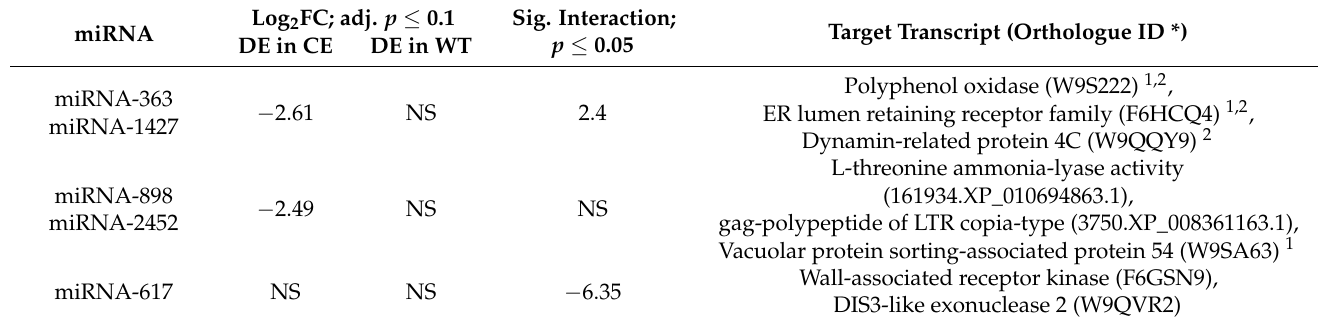
Sig. interaction is the difference between the condition effect for the resistant cultivar compared to the condition effect for the susceptible cultivar. * Orthologue ID is either UniProt (Entry) or STRING identifier. NS = not significant. 1,2 Significant genes identified in topGO analysis of biological process and molecular function ontologies, respectively, performed with targets of differentially expressed miRNAs in the susceptible cultivar. 3,4 Significant genes identified in topGO analysis of a biological process and molecular function ontologies, respectively, performed with targets of differentially expressed miRNAs in the resistant